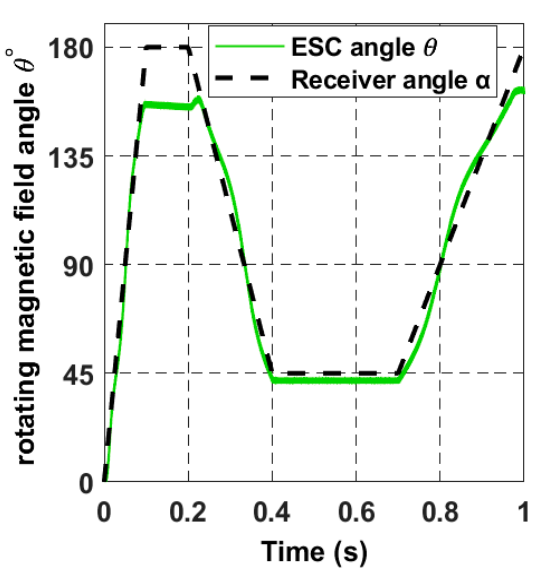
Figure 25. The rotating magnetic field angle θ in the closed-loop when the receiver moves intermit- tently.